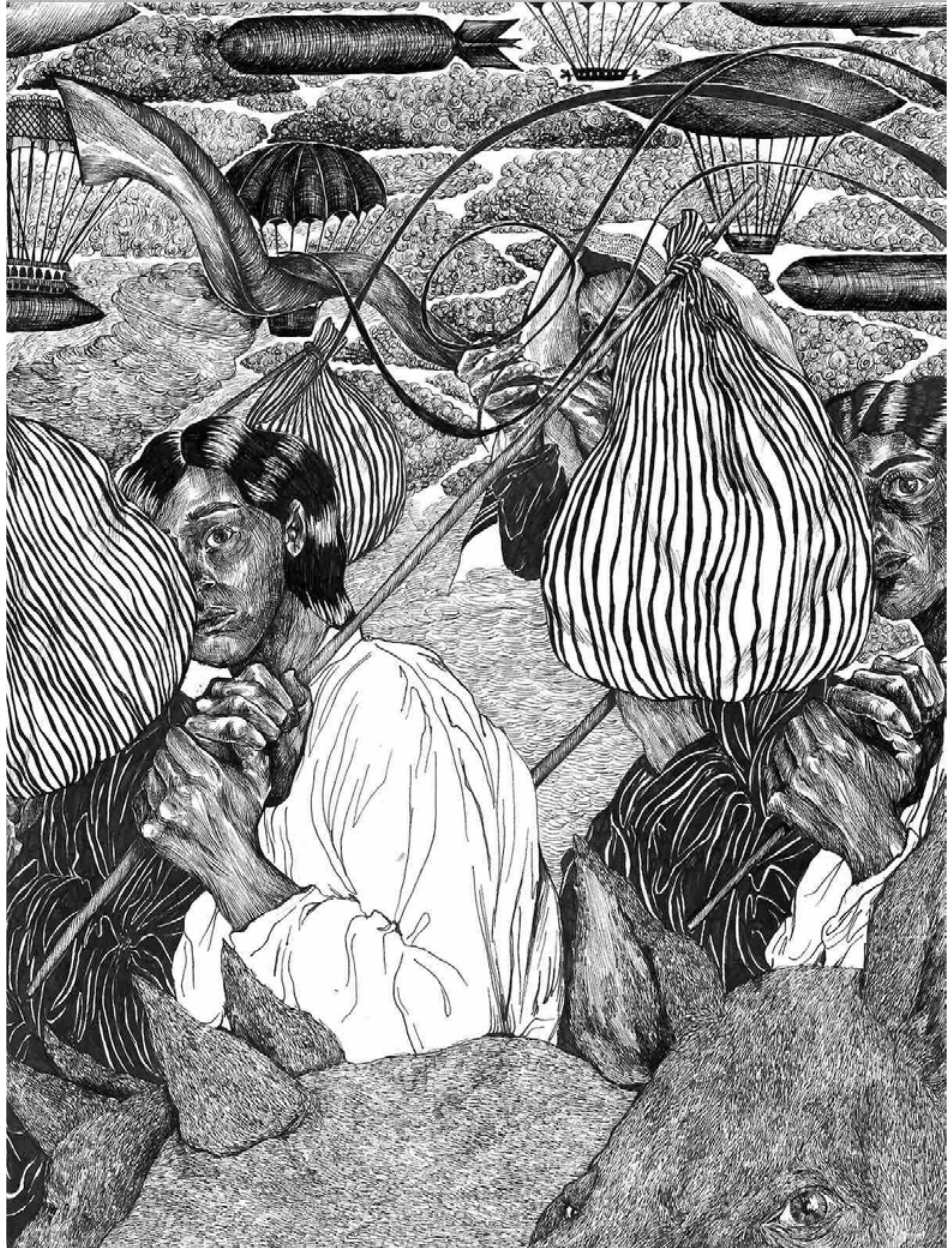
Rosabel Rosalind Kurth-Sofer, Exodus IV , 2018. Pen and ink on paper. 9x11